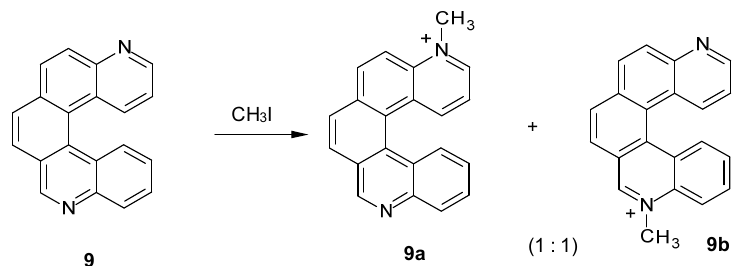
Figure 4. N - Methylation of diazahelicene ( 9